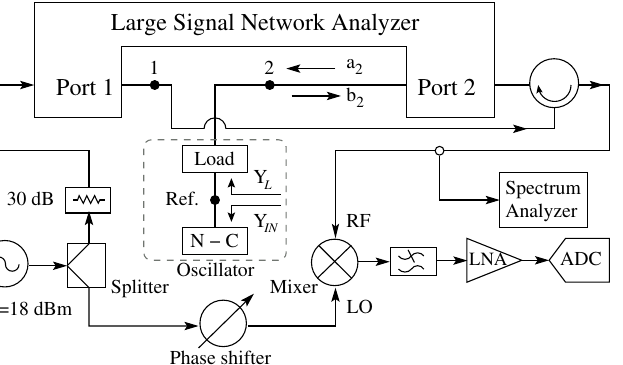
Figure 3. New additive phase noise measurement system integrated with an LSNA for a one-port injection-locked oscillator with a negative-conductance (N-C) circuit.